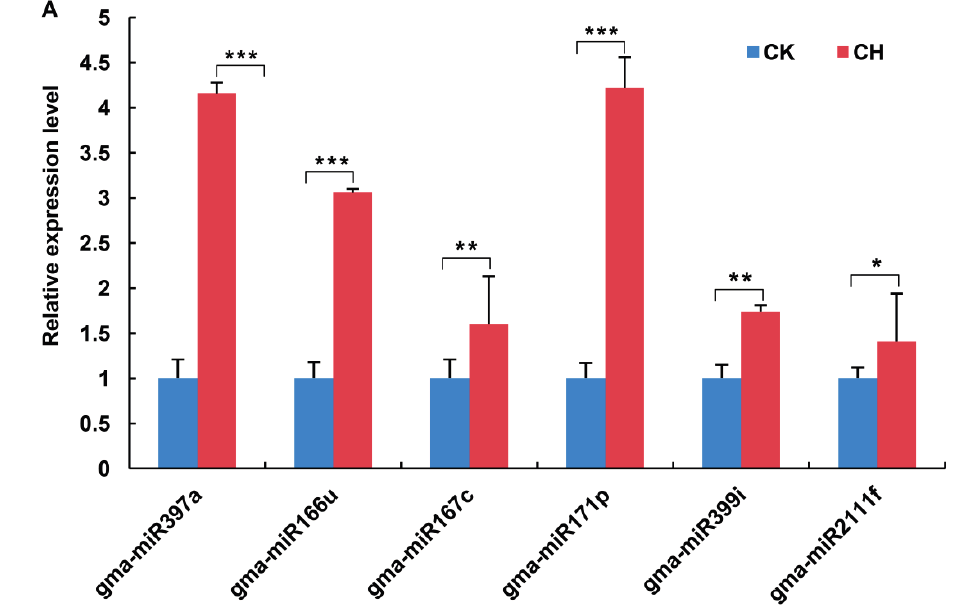
Figure 2. Quantitative reverse transcription PCR (RT-qPCR) analysis of miRNA expression in low temperature-treated mature nodules. Small RNAs were isolated from functional soybean nodules 28 days after inoculation with B. japonicum strain USDA110 in the cold (4 °C for 24 h); untreated nodules were used as a control. ( A ) The miRNAs that were up-regulated by low-temperature treatment are shown; ( B ) The miRNAs that were down-regulated by low-temperature treatment are shown. 5.8S rRNA was used as an internal control. The results shown are the averages ± SE of three biological replicates. Error bars indicate the standard deviation. Student’s t -tests were performed; statistically significant results are marked with * ( p < 0.05); ** ( p < 0.01); *** ( p < 0.001); ns: not significant ( p >